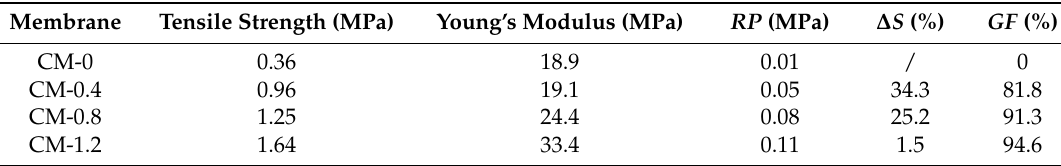
Table 1. Mechanical and swelling properties of the membranes.